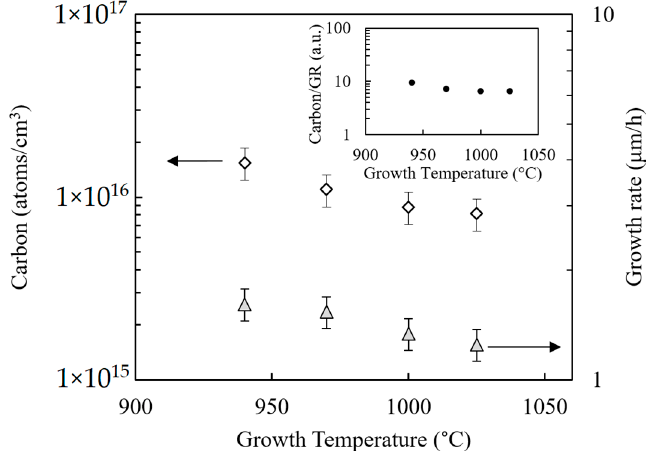
Figure 1. Carbon levels and GaN growth rates determined by Secondary ion mass spectroscopy (SIMS) analysis as a function of growth temperature for a test sample grown under Condition A. Inset: carbon concentration normalized by growth rate vs. growth temperature.